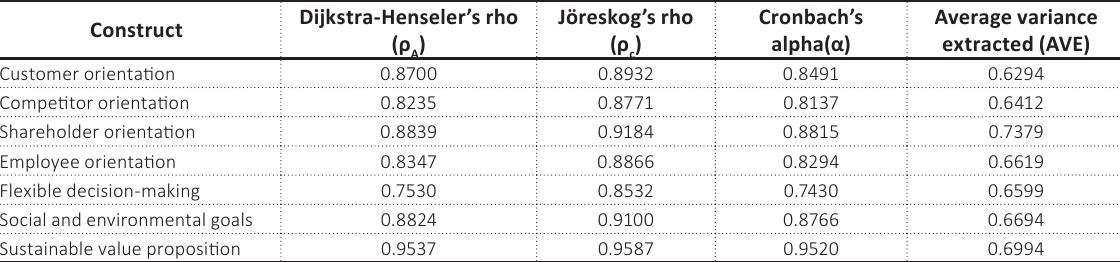
Table 2. Construct reliability